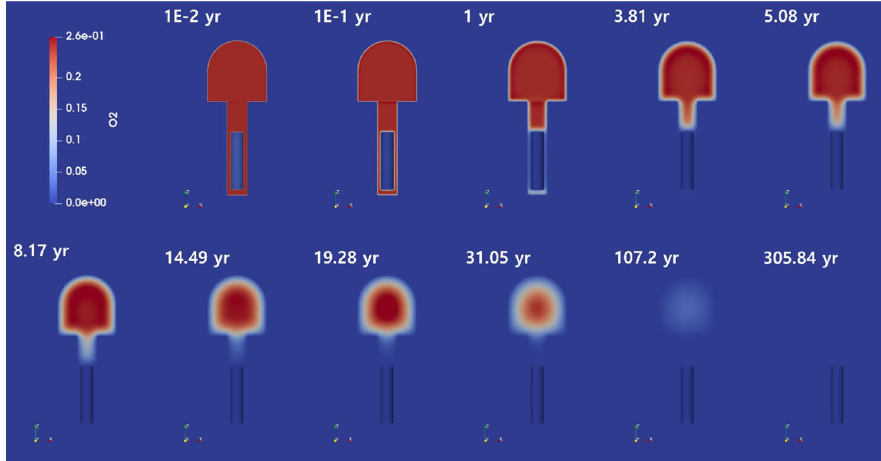
Fig. 11 Concentration pro fi le of O 2 . Distributions of O 2 in engineering barrier system (disposal turner, bentonite, and canister).